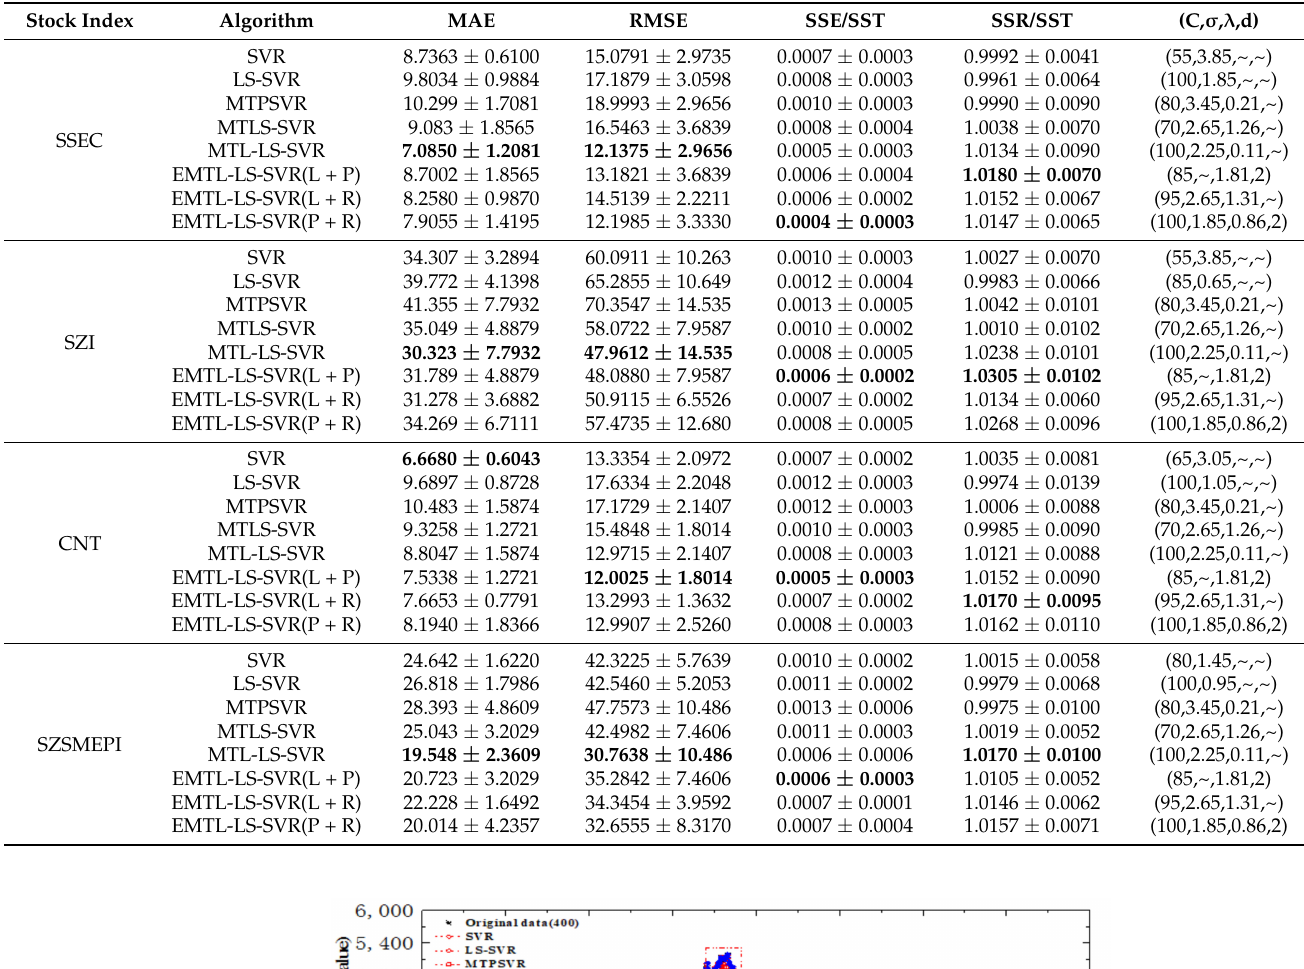
Table 1. Performance comparisons of eight algorithms on four major stock market indices.